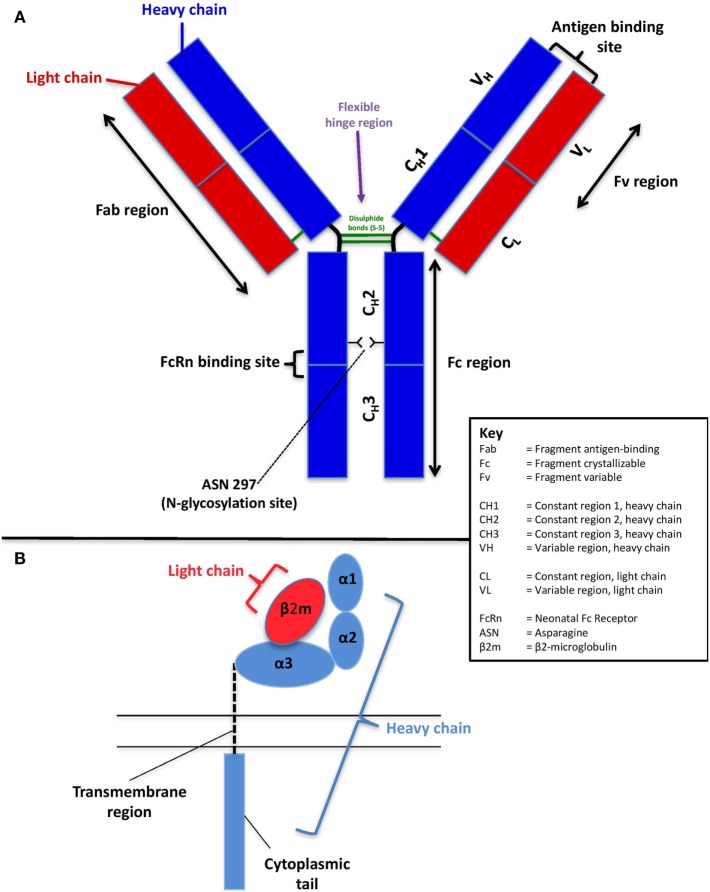
Schematic of the structure of human immunoglobulin G (A) and the neonatal Fc receptor (B).